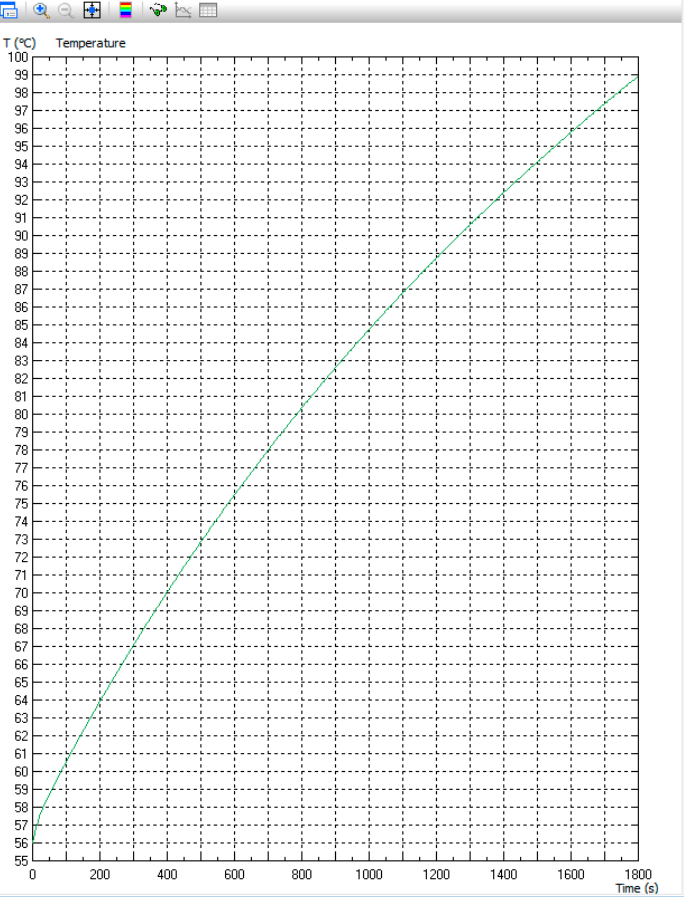
Figure 11. The temperature changes of the AMD ferrite ring for 1800 s.